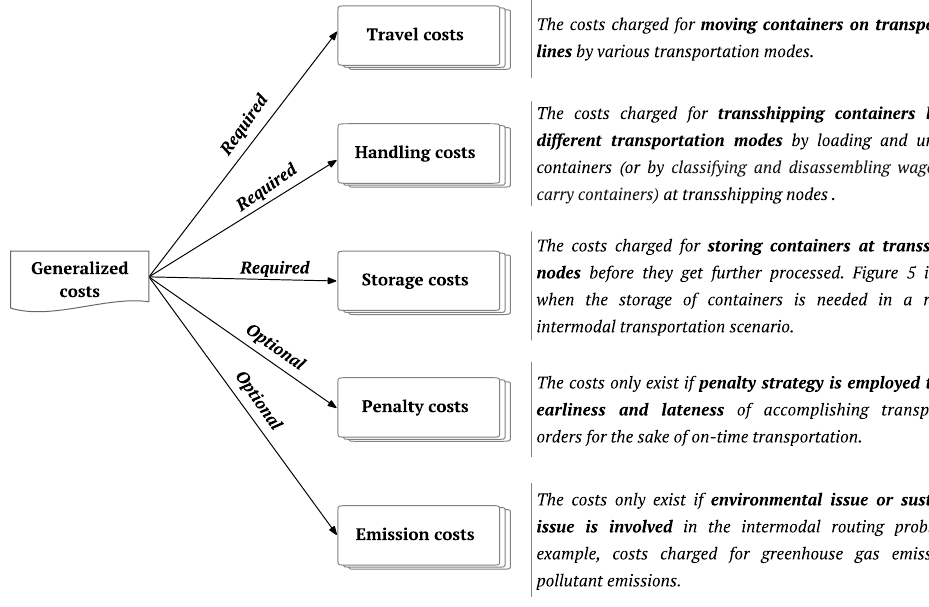
Figure 2. Structure of the generalized costs.